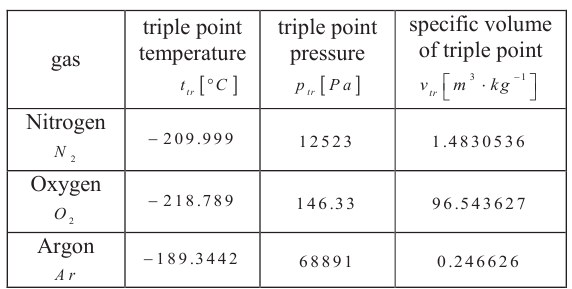
Table 4 . Parameters of the triple point tr of dry air components [2].